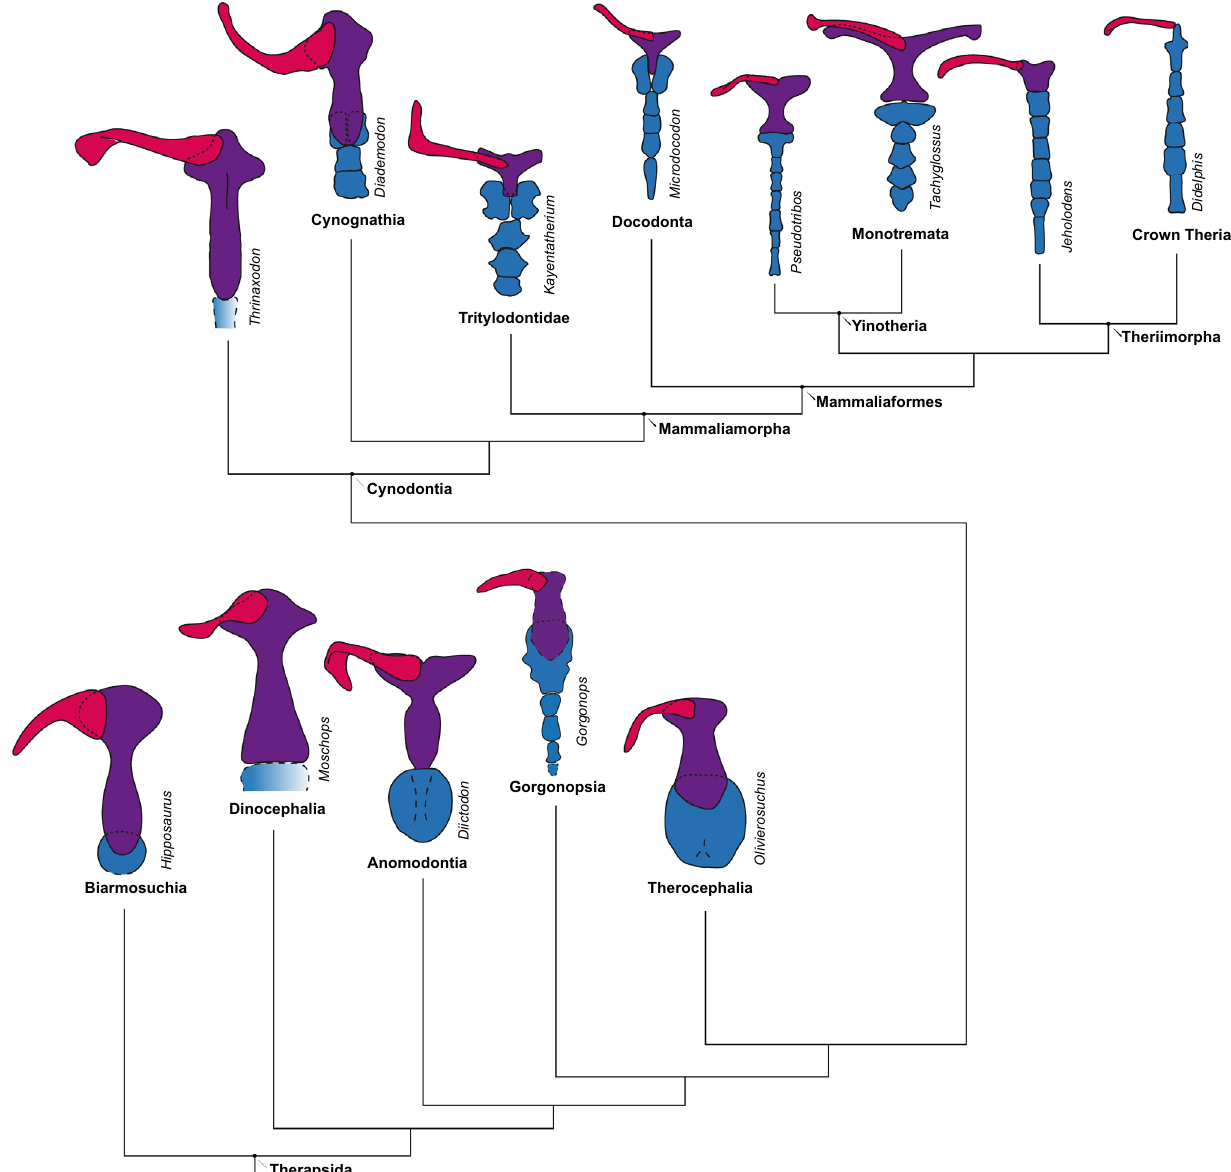
Figure 1. Schematic representation after Luo et al. 10 of the evolution of the pectoral girdle elements interclavicle (purple), clavicle (pink) and sternum (blue) in the major therapsids clades Biarmosuchia ( Hipposaurus 26 ), Dinocephalia ( Moschops 29 ), Anomodontia ( Diictodon 20 ), Gorgonopsia (SAM-PK-K10591, Gorgonops torvus ), Therocephalia ( Olivierosuchus 21 ) and the cynodont Thrinaxodon 71 , as well as Cynognathia ( Diademodon 14 ), Tritylodontidae ( Kayentatherium ), Docodonta ( Microdocodon 9 ), Yinotheria ( Pseudotribos 10 and the monotreme Tachyglossus (drawing after specimen ZMB-35995 in the Museum für Naturkunde, Berlin) and Theriimorpha ( Jeholodens 10 and the crown therian Didelphis 10 ). All views from ventral. Simplified phylogeny after Hopson and Barghusen 24 and Sidor and Hopson 25